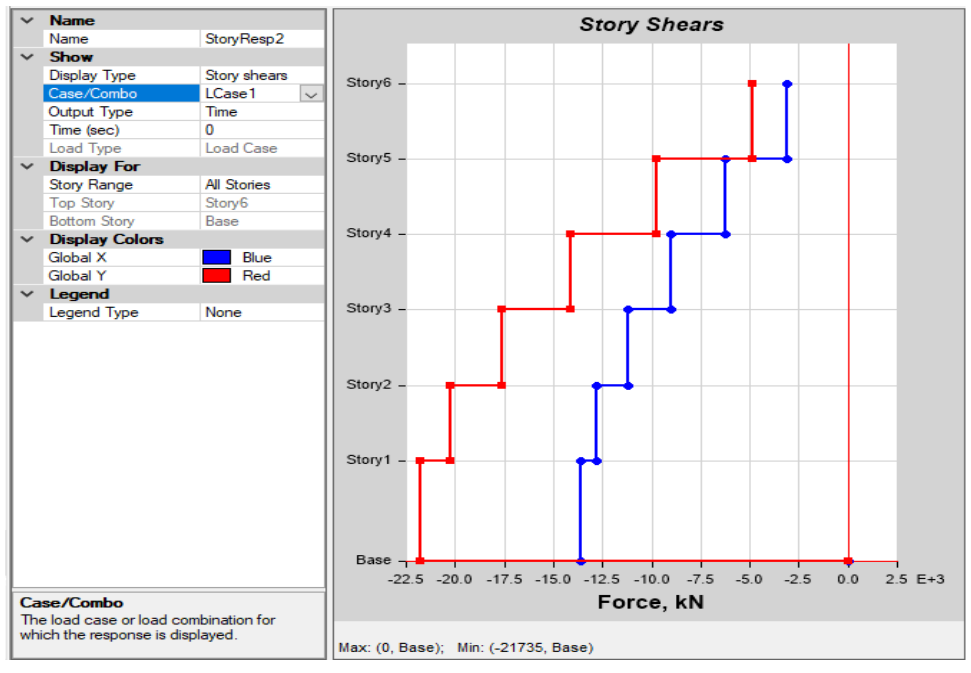
Figure 16. Maximum story shear.